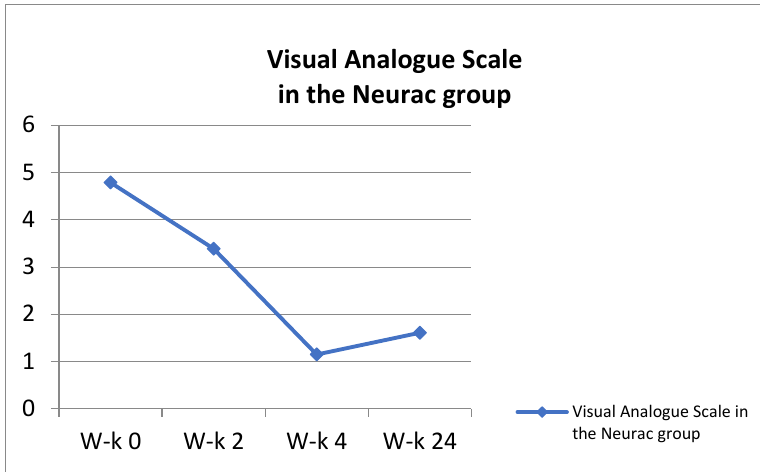
Figure 5. Visual Analogue in the Neurac group.